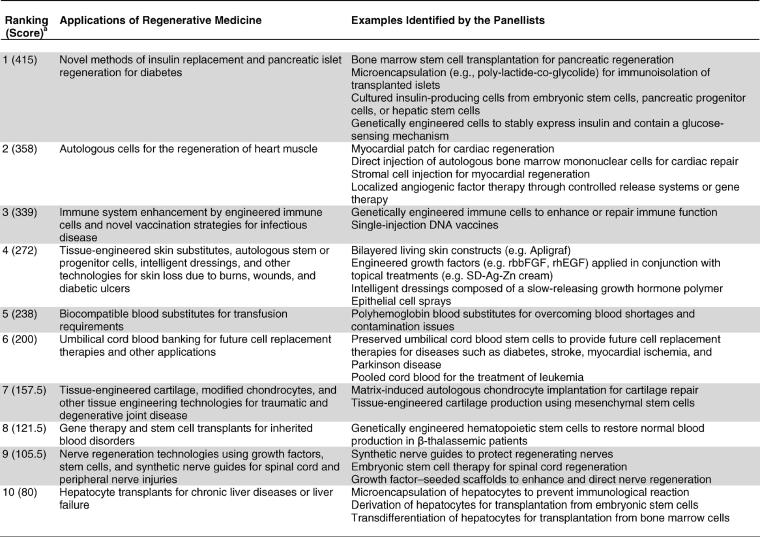
Top Ten Regenerative Medicine Applications for Improving Health in Developing Countries aThe maximum total score an application could receive was 440.